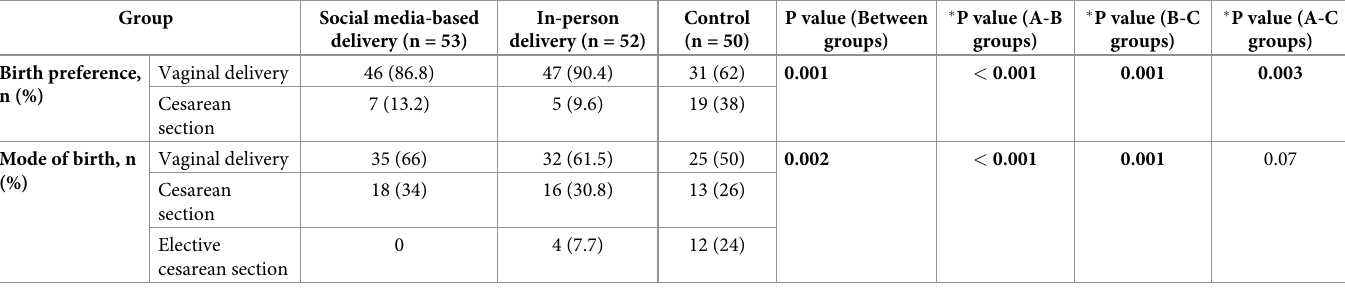
Table 4. Between-group and within-group comparison of birth preference and mode of birth in three groups.